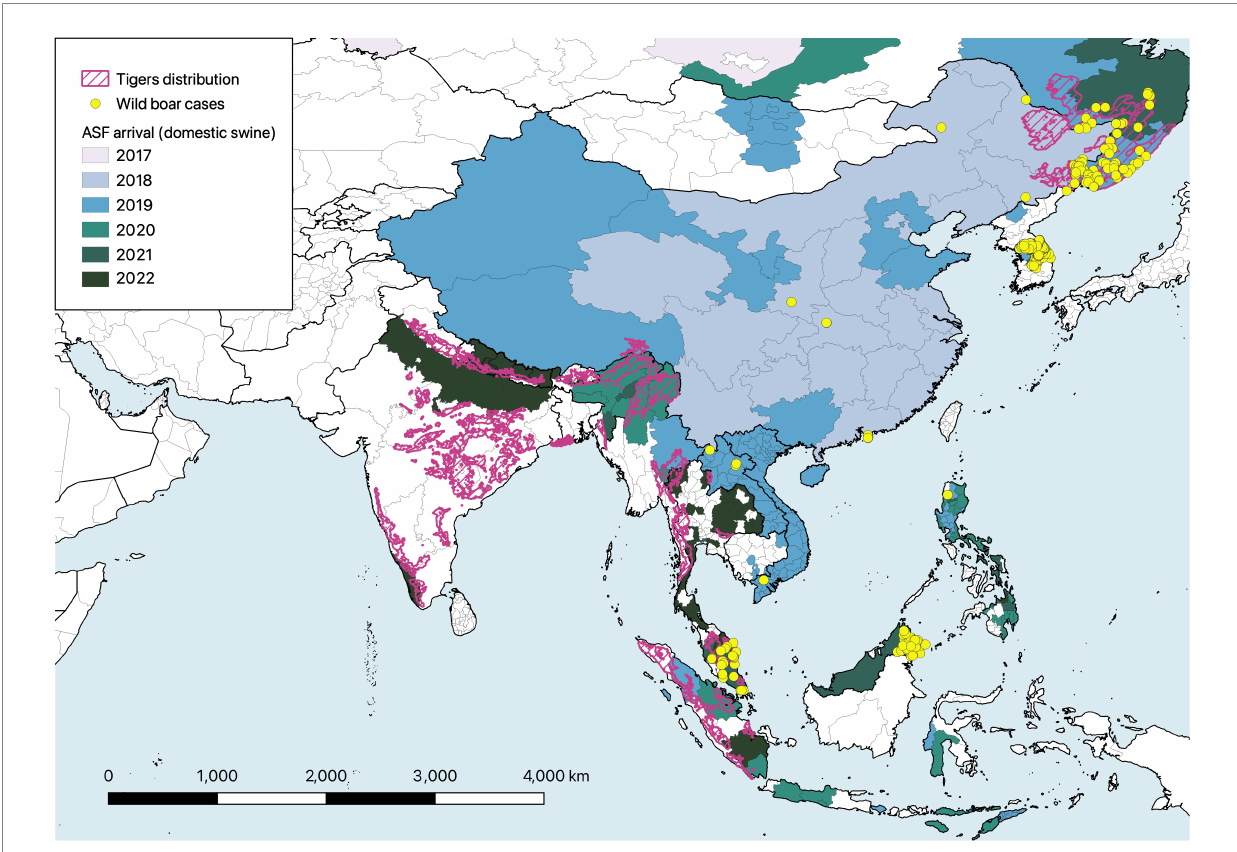
FIGURE 2 Map illustrating the spread of African swine fever (ASF) across Asia in relation to current tiger distribution (IUCN SSC Cat Specialist Group, 2022). Colors illustrate the year of first detection in domestic pigs at the province level (or equivalent) between August 2018 and December 2022. Location of ASF cases in wild boars are illustrated by yellow points. Source of ASF data: World Organisation for Animal Health - World Animal Health Information System (https://wahis.woah.org/#/event-management), accessed 6 February 2023, and Food and Agriculture Organization of the United Nations - EMPRES-i+ Global Animal Disease Information System (https://empres-i.apps.fao.org/diseases), accessed 3 March